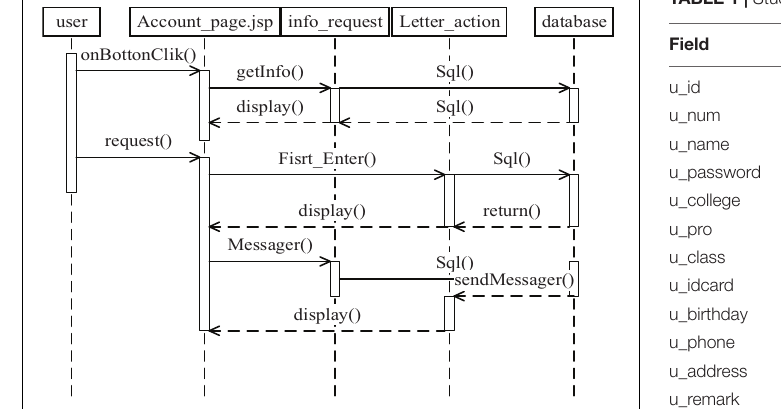
TABLE 1 | Student information table.